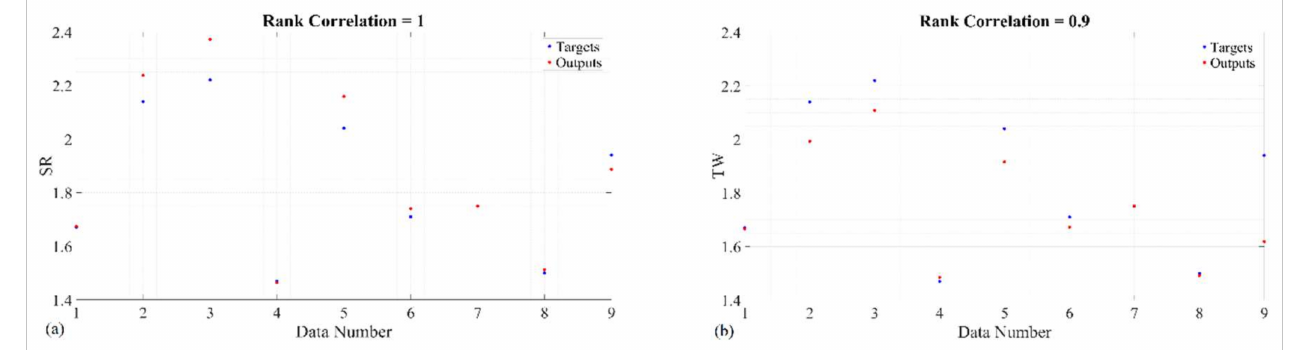
Figure 5. The actual and predicted outcomes during whole data including testing and training using ( a ) ANFIS-SR; ( b ) ANFIS-TW.